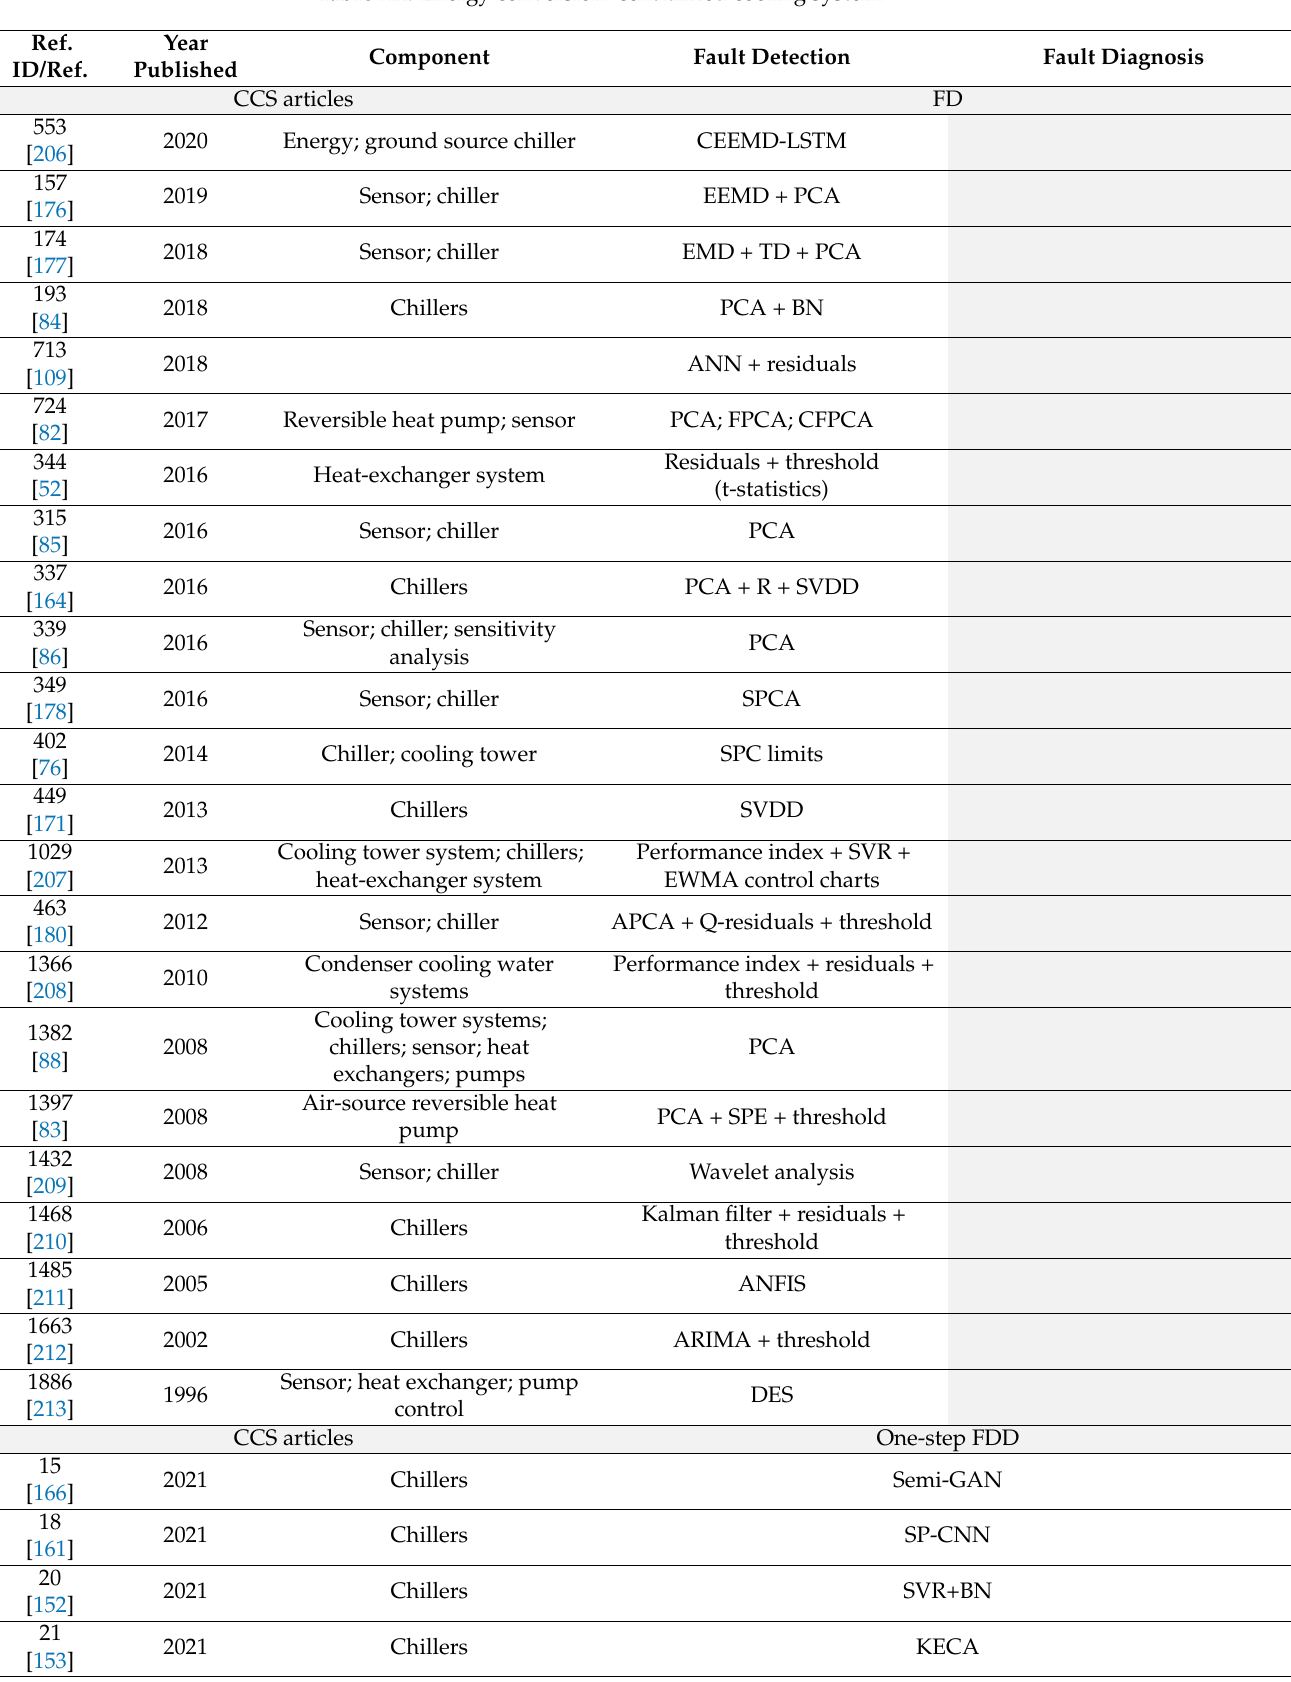
Table A2. Energy conversion: centralized cooling